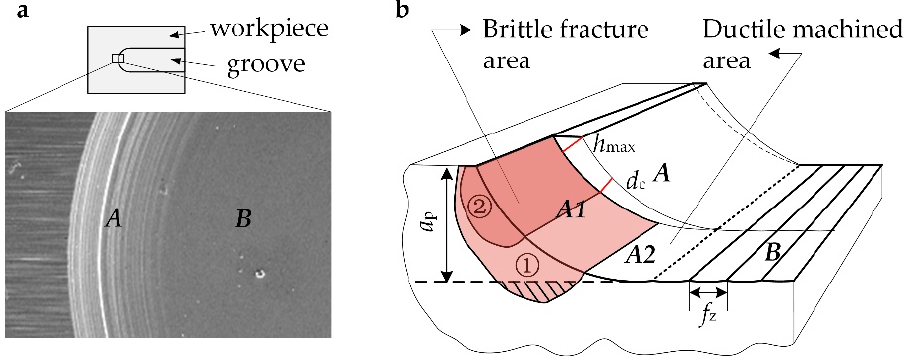
Figure 5. Schematic sketch of machined surface on groove edge: ( a ) different surface morphology of area A and B; ( b ) illustration of the effect of the brittle failure zone on the machined surface.